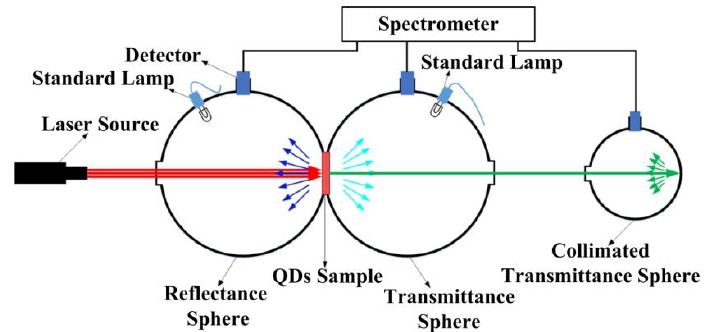
Figure 1. Schematic of the double integrating sphere testing system.